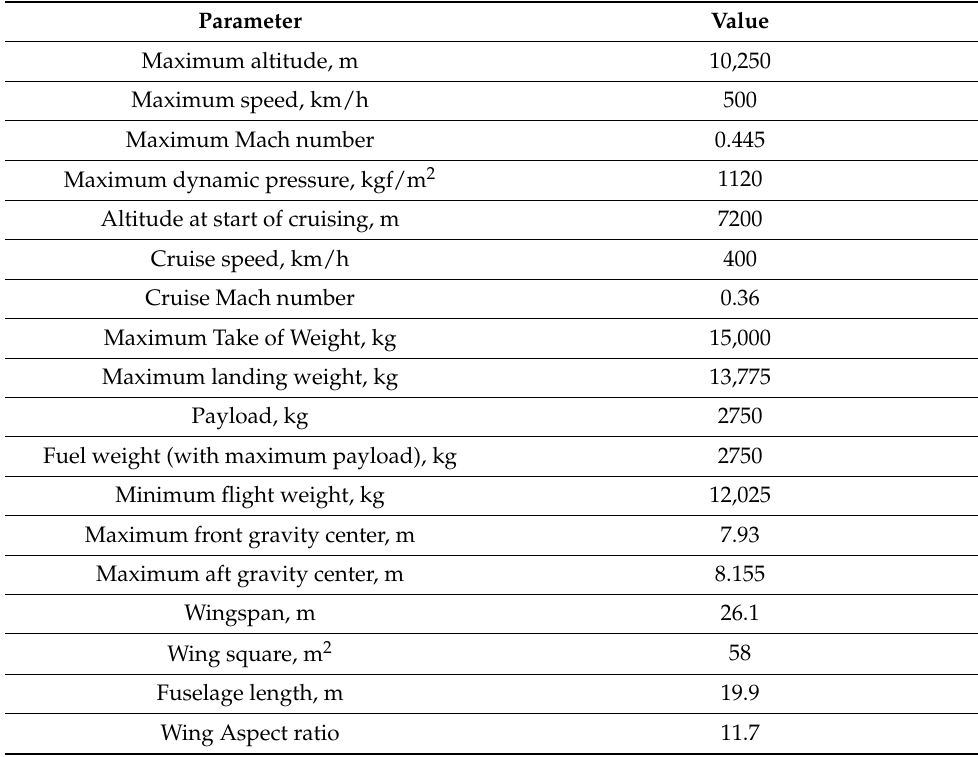
Table 1. General characteristics of base aircraft configuration.